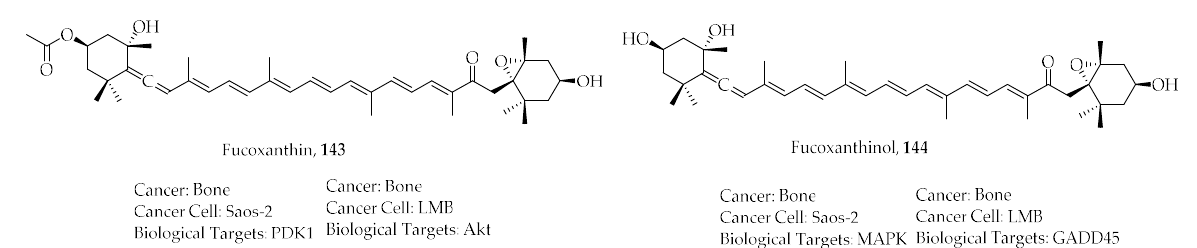
Figure 32. Structures of the non-provitamin A carotenoid Fucoxanthin and its derivative Fucoxanthinol with a summary of their biological activity towards selected cancer targets.